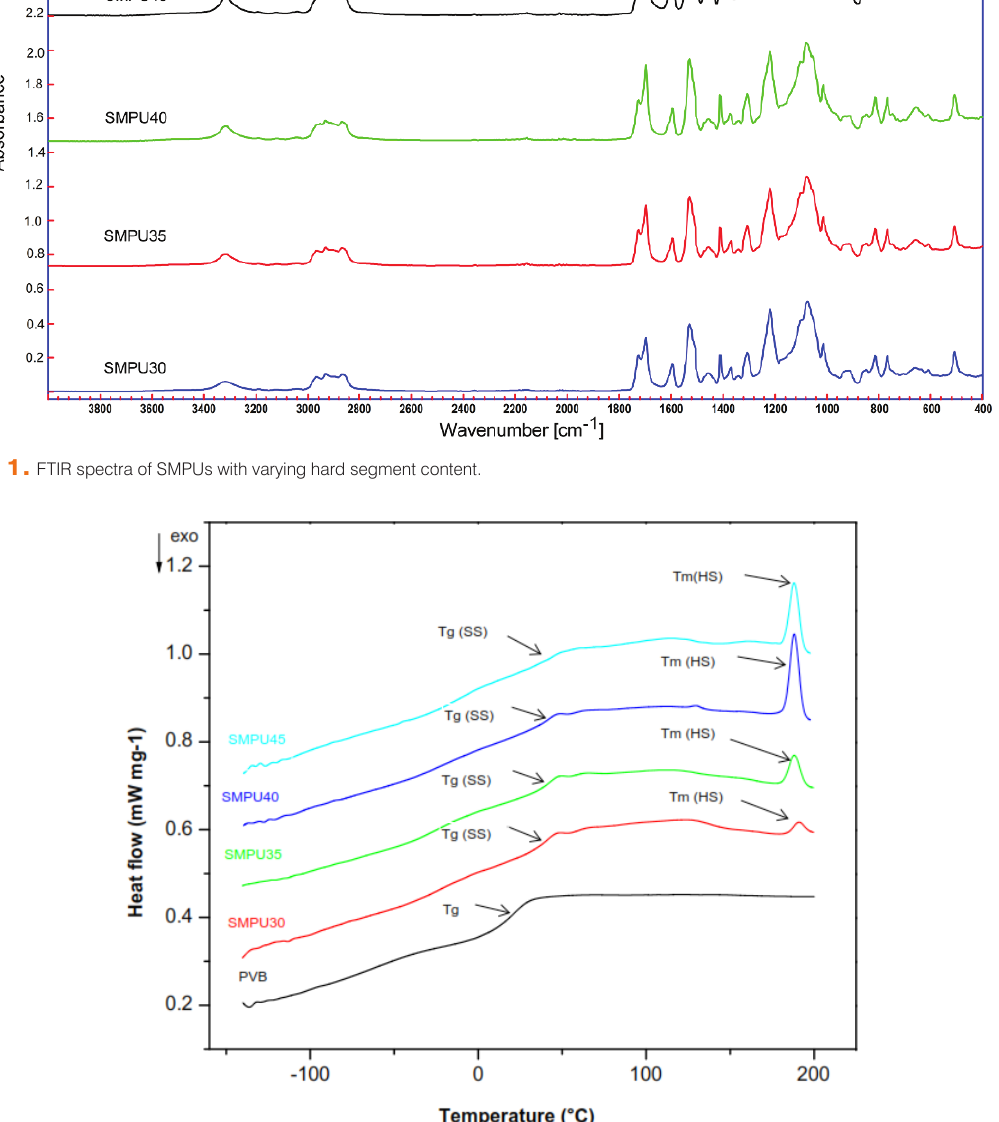
Figure 2. DSC heating curves of SMPUs with varying hard segment